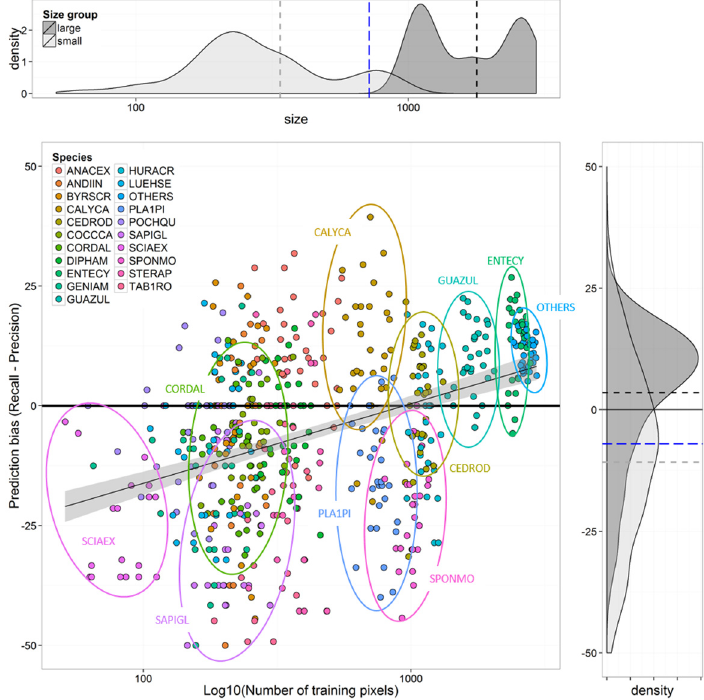
Figure 5. Relationship between class sample size and model prediction bias. Line shows a linear model with 95% confidence interval around the mean. Histogram on the top (number of pixels) and left (prediction bias) show distributions of large and small species-classes based on a 1000 pixel threshold. Dashed blue lines show mean values of size and bias for all data, and light and dark grey dashed lines show means for small and large groups, respectively. Full species names for each species code are given in Table 2.